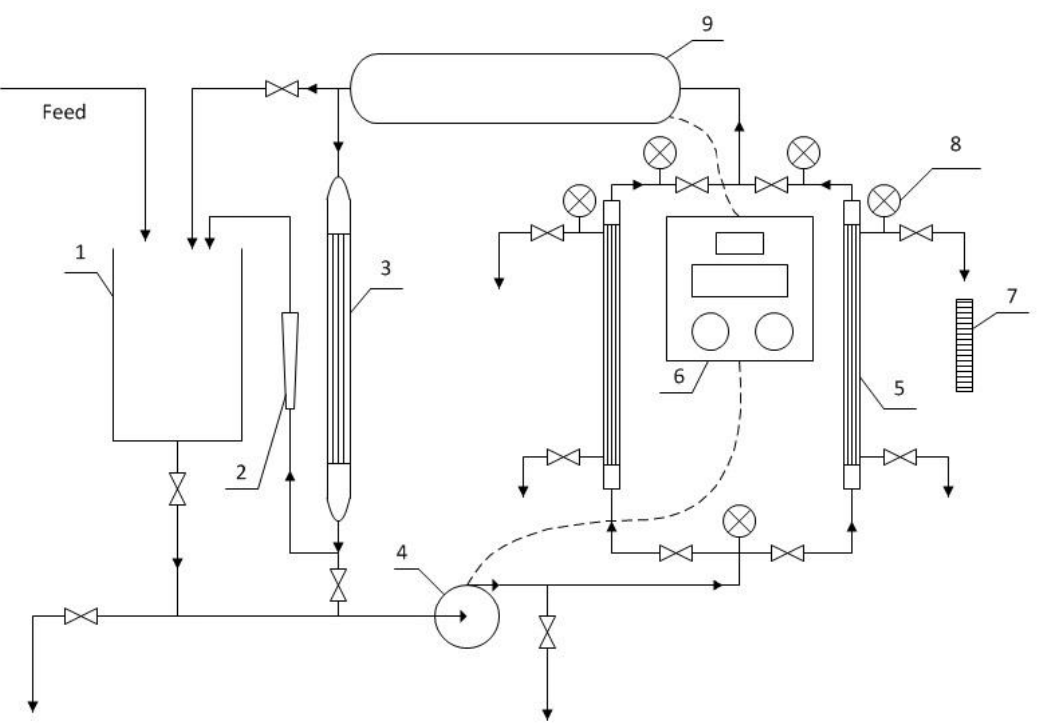
Figure 1. Pilot installation of the NF process: 1 — feed tank; 2 — rotameter; 3 — heat exchanger; 4 — pump; 5 — membrane module; 6 — temperature and flow rate controller; 7 — permeate measuring cylinder; 8 — pressure gauge; 9 — heater. Table 1. Compositions of investigated solutions